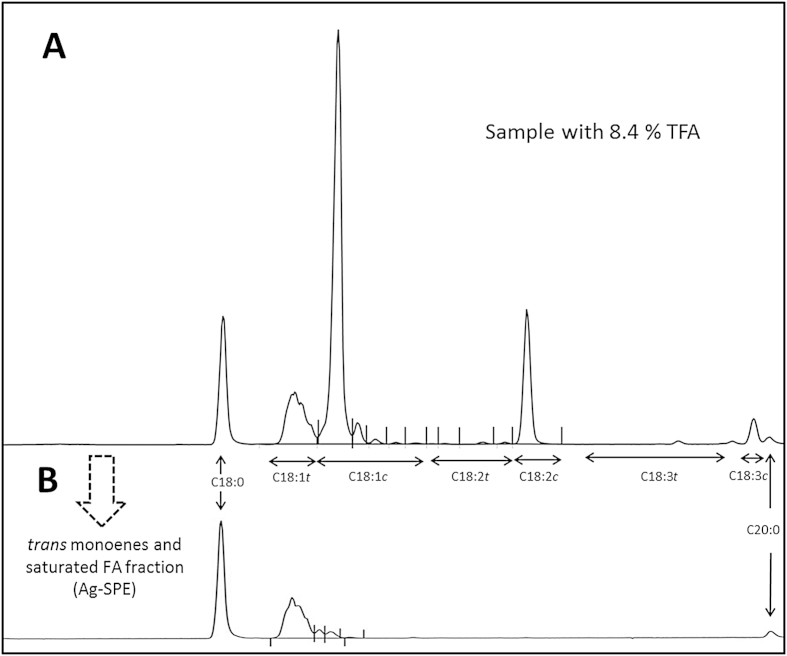
Chromatogram of a high TFA sample (A), with the detail of the trans-monoene fraction isolated by Ag-SPE (B).